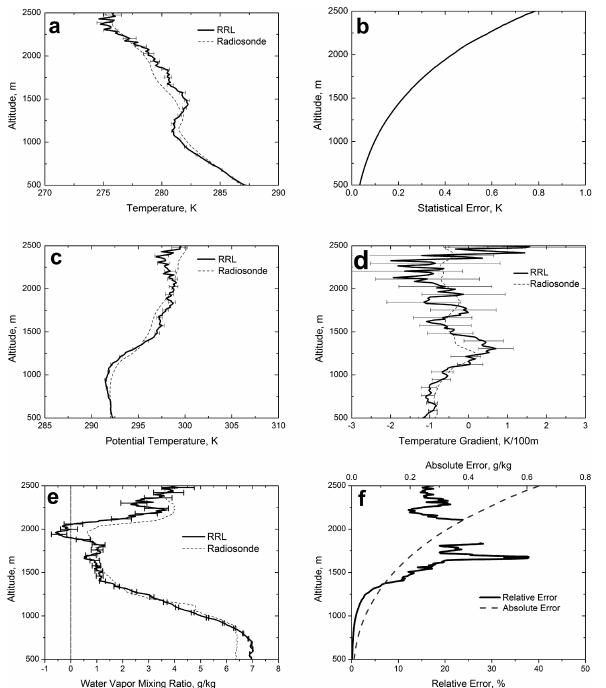
Figure 15. Measurements of the UHOH RRL between 13:00 and 13:30UTC on 19 May 2013 with data of a local radiosonde launched at 13:00UTC (dashed) for comparison. (a) Temperature, (b) statistical temperature error, (c) potential temperature (d) , tem- perature gradient (e) , water vapor mixing ratio, and (f) absolute and relative error of water vapor mixing ratio. Values of absolute error in the height range where the mixing ratio shows negative values are omitted. Error bars show the statistical errors of the lidar data. Alti- tudes below 500m are affected by non-total overlap and are there- fore not shown.